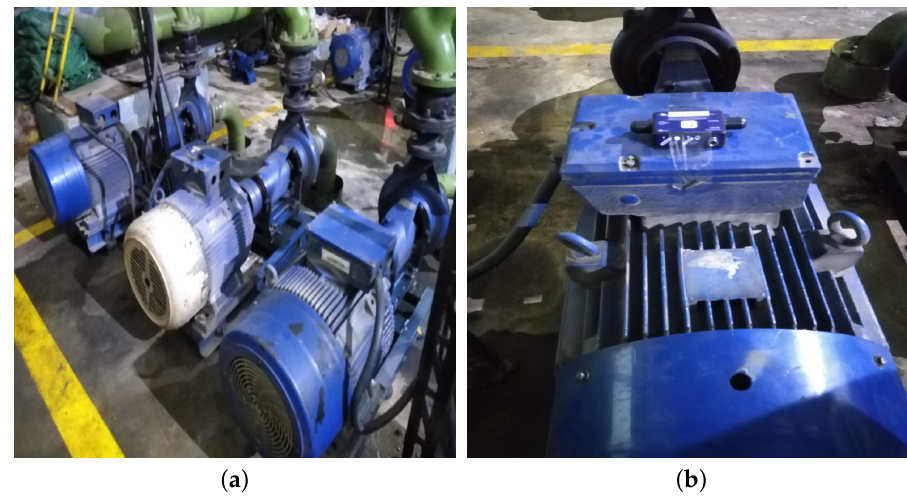
Figure 2. Data Acquisition Setup. ( a ) Motor Assembly. ( b ) Accelerometer Placement.